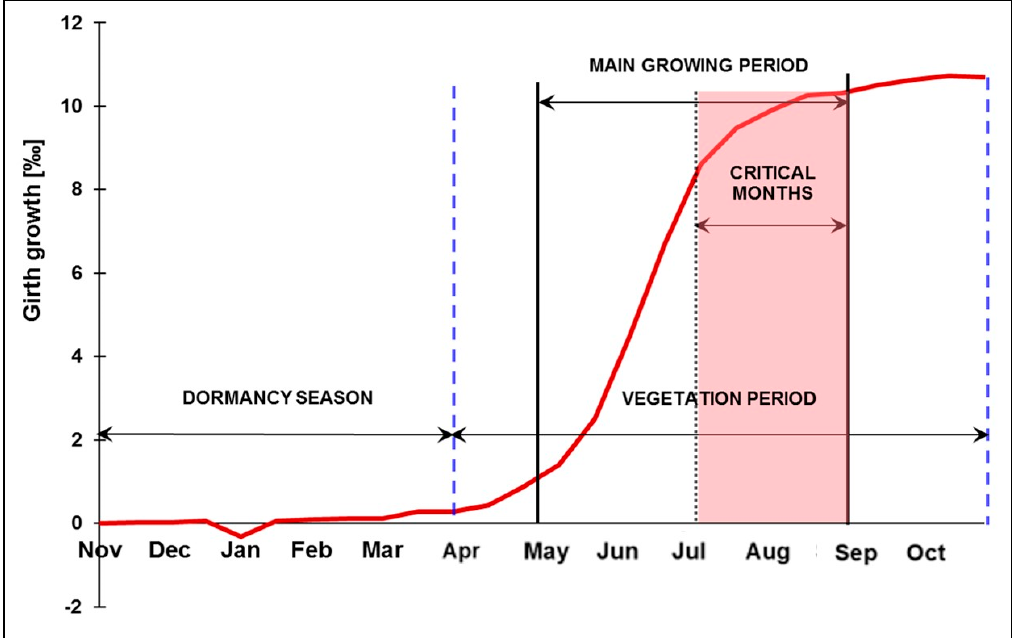
Figure A1. Mean annual cycle of girth increment of tree species in Hungary, on the example of beech (design by B. Gálos, see also [40,42]).